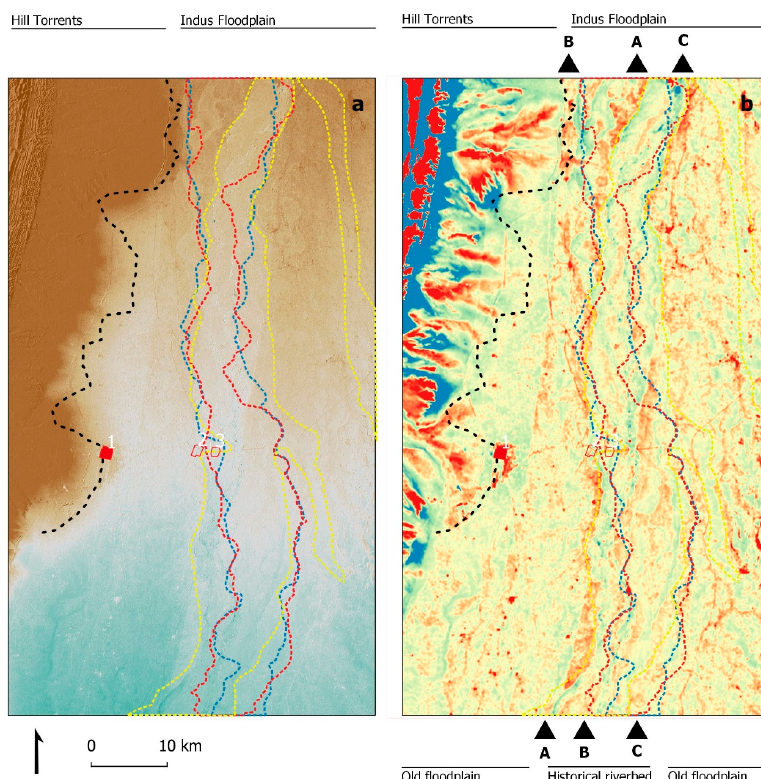
Figure 6. General view of the relief analysis: ( a ) ALOS DEM; ( b ) derived MSRM. Blue represents relative lower areas and red higher areas. Dotted lines represent the limit of hill torrents irrigation systems (black), and the active floodplain in 1907 (blue) and 1944 (red) (see Figure 2). In this area can be identified the actual Indus West levees (A) and historical levees West (B) and East (C). Old floodplains occupy the area between the Suleyman mountain hill-torrent deposits (W) and Indus tributaries (E). Inactive floodplain is irrigated by inundation channels. The micro-topographic analysis show depressions and old river channels occasionally flood. Like the previously mentioned 2010 event (yellow dotted line). The west paleochannel reported in the Gazetteer was not clearly indicated on the SoI 1” to 1-mile map produced in 1907 (39/J/16/1907), but it appears in the map edited after the flood